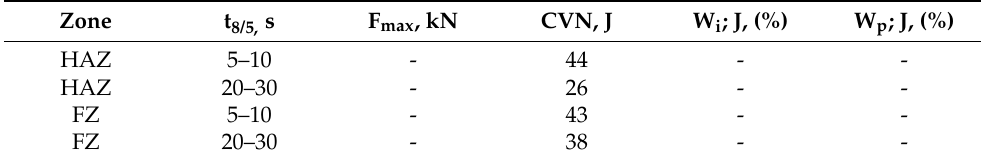
Table 12. Charpy V-notch impact test results on GMA-welded S960QL joints data from [26].